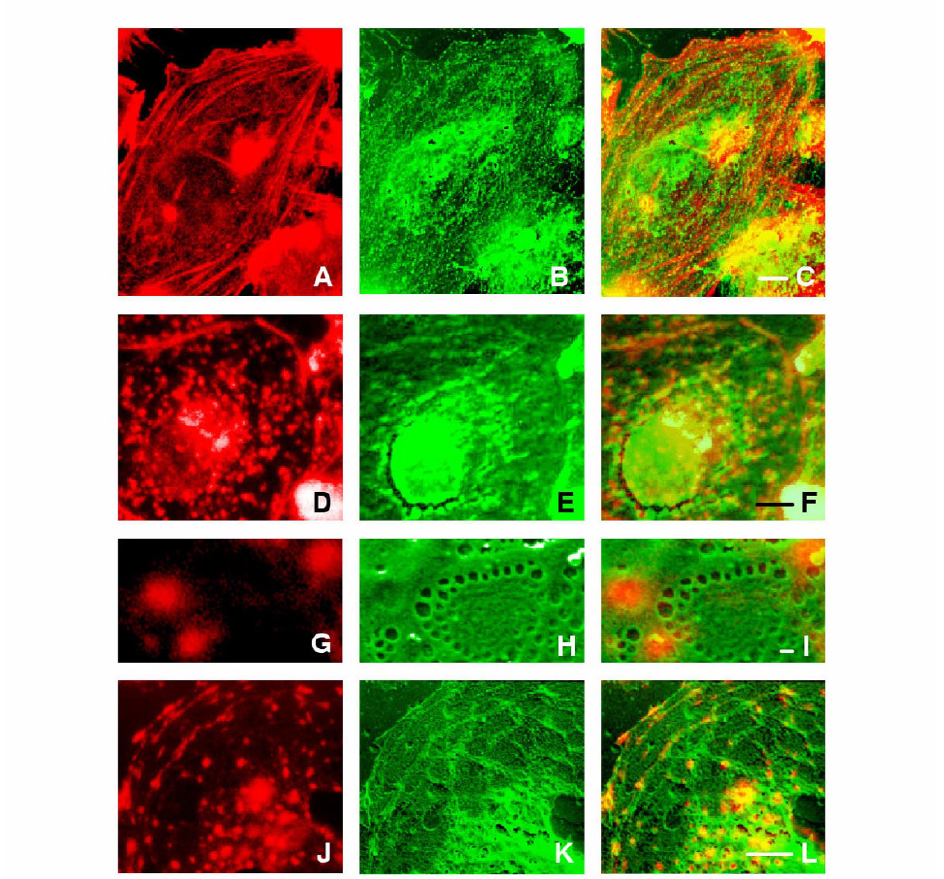
Figure 6 Correlative fluorescence-, and SEM micrographs of control (A-C) and microfilament-disrupted LSECs obtained after 10 min (D-F), 60 min (G-I) and 120 min (J-L) di-h-HALI treatment. Figure set shows simultaneous localization of fluorescent labeled F-actin (red) (left column) in combination with topographic SEM information (green) (middle column) and the merged image (right column) of the same cell. Control LSECs show features similar as those seen in Figs. 1A and 2A: i.e., a well developed filamentous actin cytoskeleton ( A ) and sieve plates ( B ). The merge image ( C ) reveals that the fenestrated areas are clearly interspersed between the actin filaments. Scale bar, 2 µ m. After 10 min di-h-HALI treatment ( D- F ), the images show that the brightly stained F-actin dots matches with the fine globular topographic elevations present on the thin nonfenestrated cytoplasmic arms. Within one hour of di-h-HALI treatment ( G-I ), the merge image of the fenestrated area reveals that the FFC and the area around is devoid of F-actin. Scale bar, 200 nm. ( J-L ) Images obtained after 120 min of di-h- HALI treatment. Note that the F-actin dots are localized in the thin nonfenestrated cytoplasmic arms; while the highly fenes- trated cytoplasm lacks F-actin. Scale bar, 2 µ